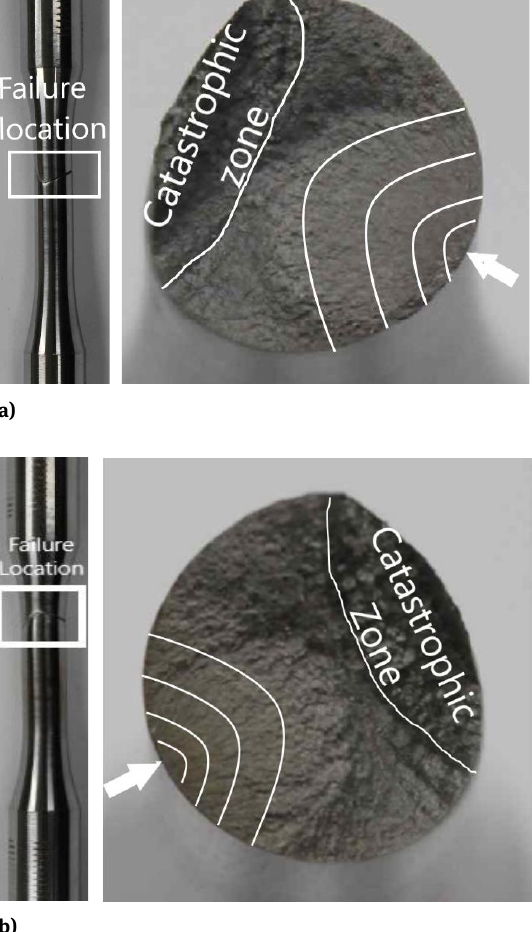
Figure6exhibitsthePDFcurveofthefatiguelimitwith